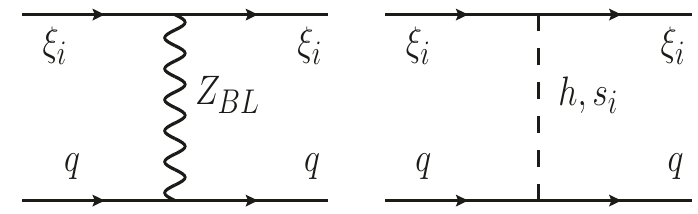
Figure 3 . Feynman diagrams for spin-independent elastic scattering processes of DM with nucleons (or quarks) in the